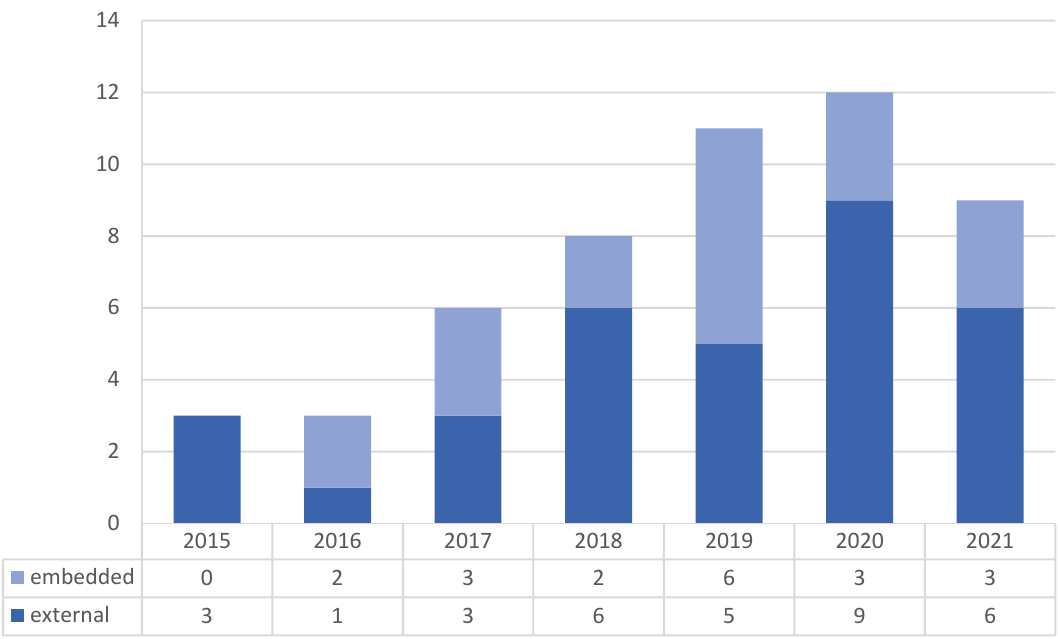
Figure 2. Distribution of data collection methods through 2015–2021.